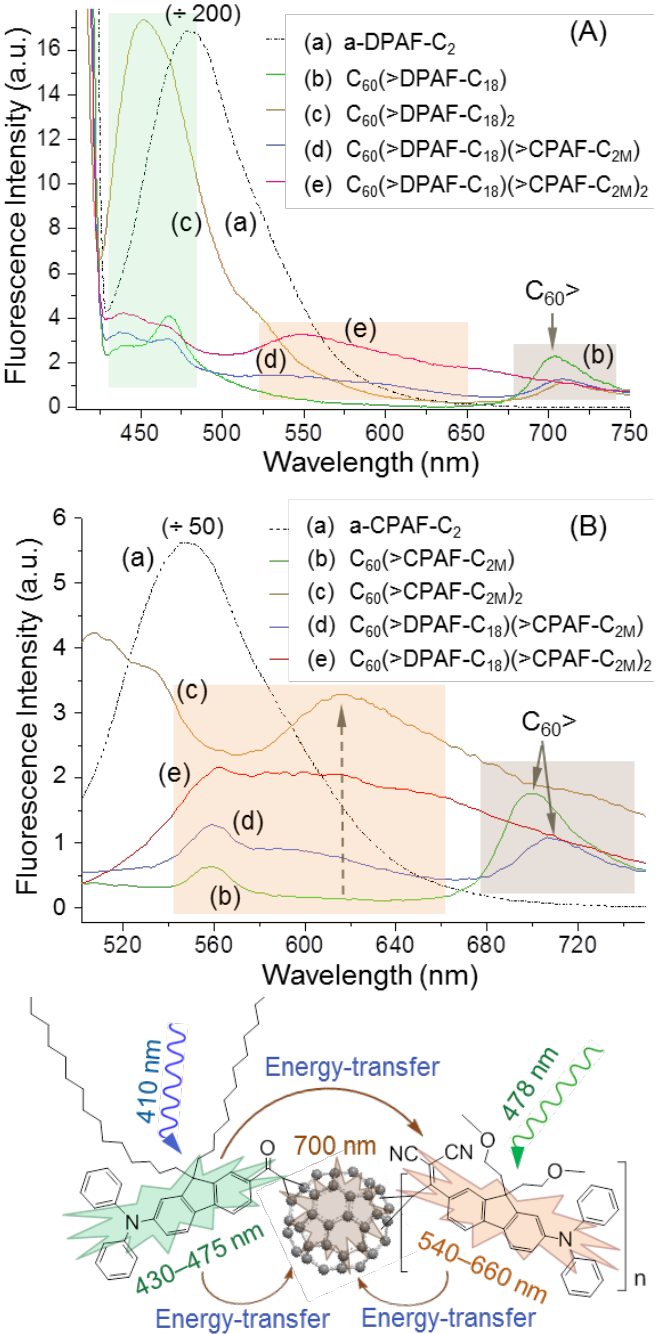
(>CPAF-C ) , ( d ) 3 , and ( e 60 2M 2